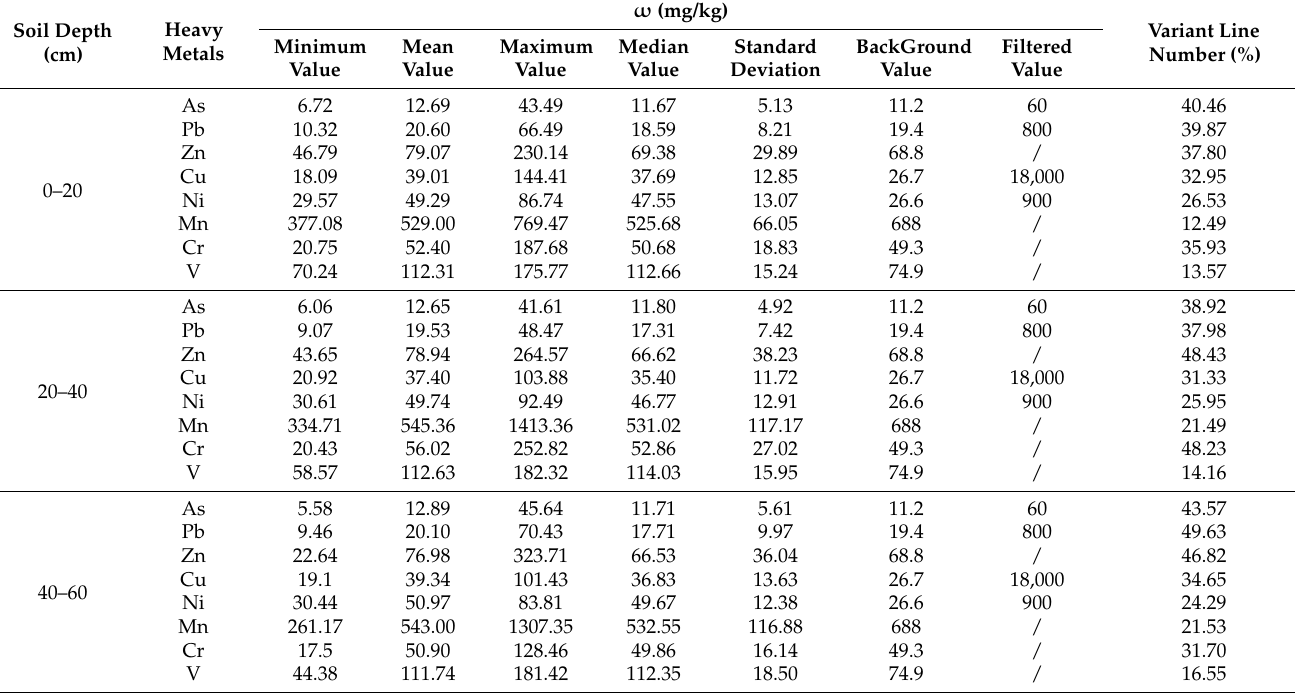
Table 1. Statistical analysis results of heavy metals in soils along the Shuimo River.